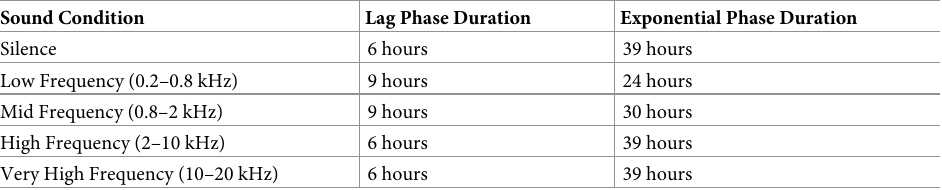
Table 2. Growth phases of S . cerevisiae US05 in response to sound